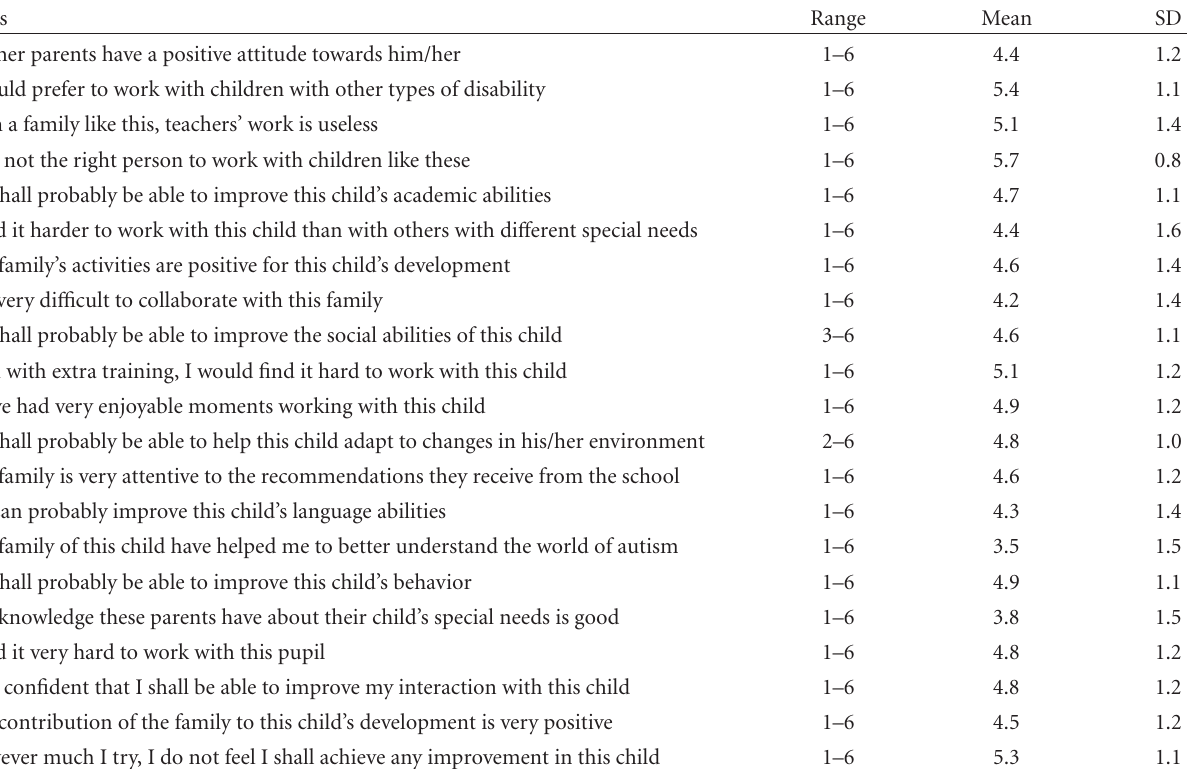
Table 1: Mean and standard deviation of items included in the teacher attitude questionnaire (scores for negative items have been inverted) ( N =